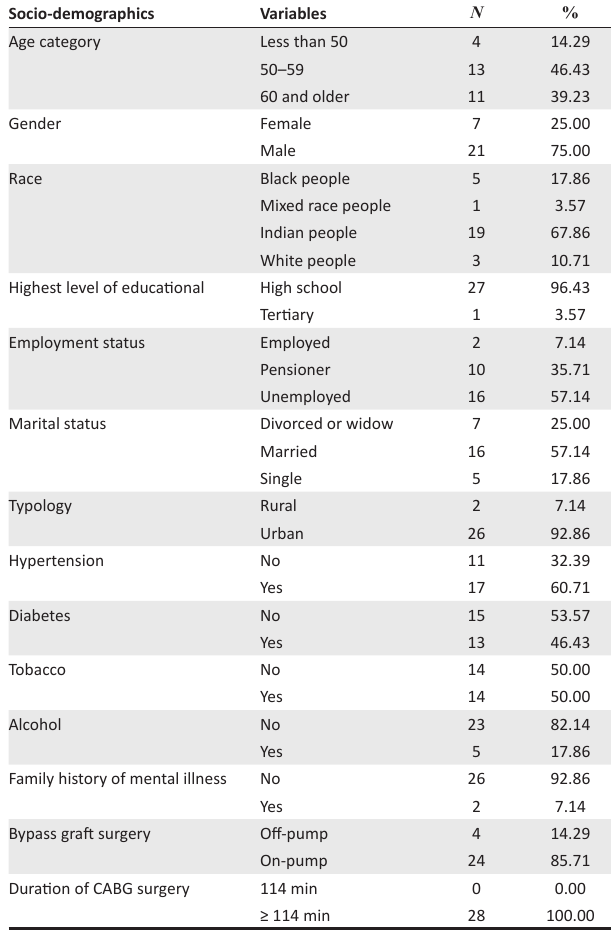
TABLE 1: Socio-demographic and clinical profile of study participants ( N =